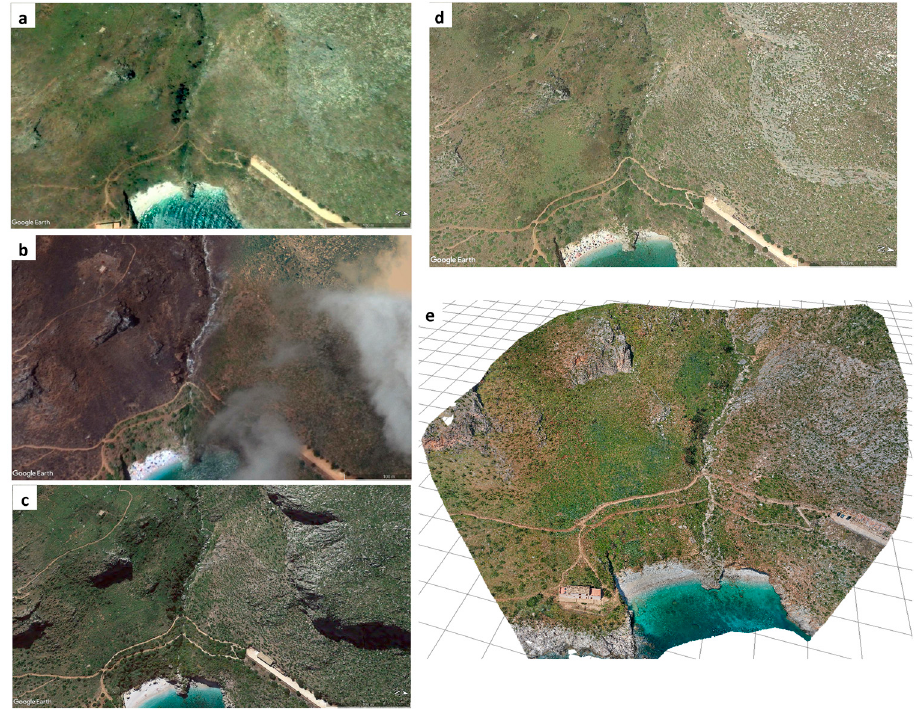
Figure 6. Temporal evolution of the filling of the channel and the progressive increase (from 2003 to 2021) in detritus after fires ( b ) and rainy winter events in 2020 ( e ). Images from Google Earth: ( a ) 2003; ( b ) 2012; ( c ) 2015; and ( d ) 2019. ( e ) Orthomosaic derived from UAV surveys (2021).